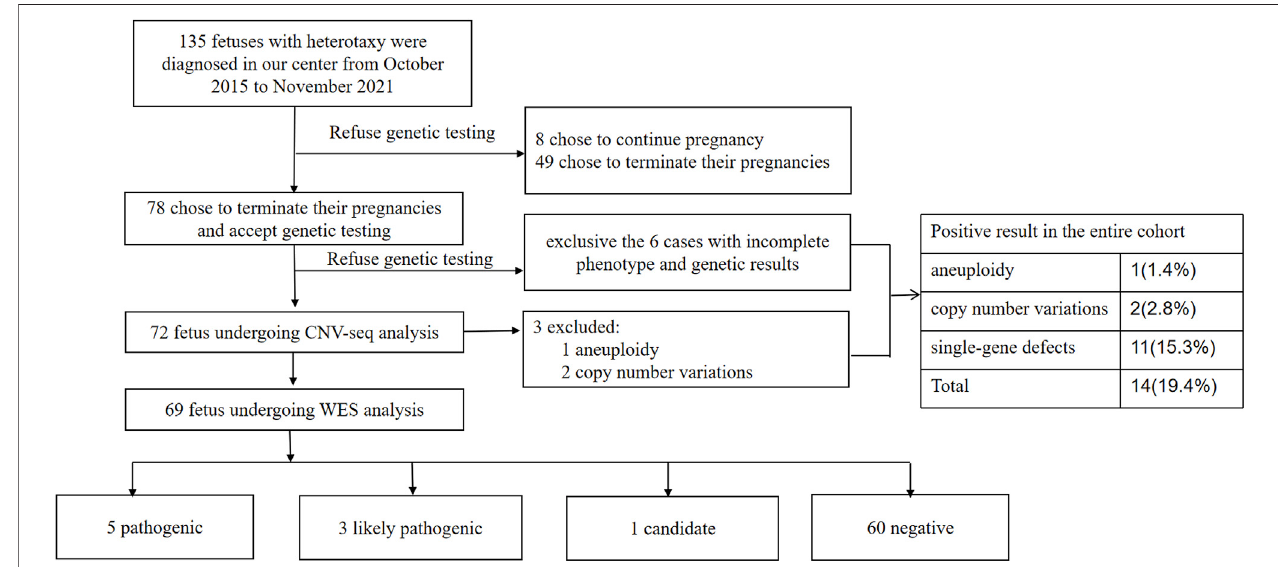
FIGURE 1 | Flowchart summarizing detection of genetic variants by CNV-Seq and WES performed in 72 prenatal samples with heterotaxy. CNV, copy number variation; WES, whole-exome sequencing.